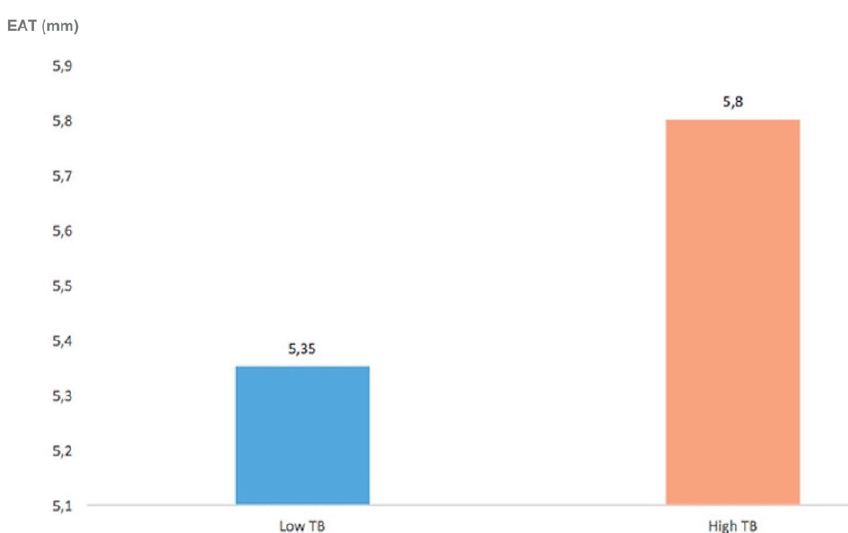
Fig. 1. The EAT value between low vs high thrombus